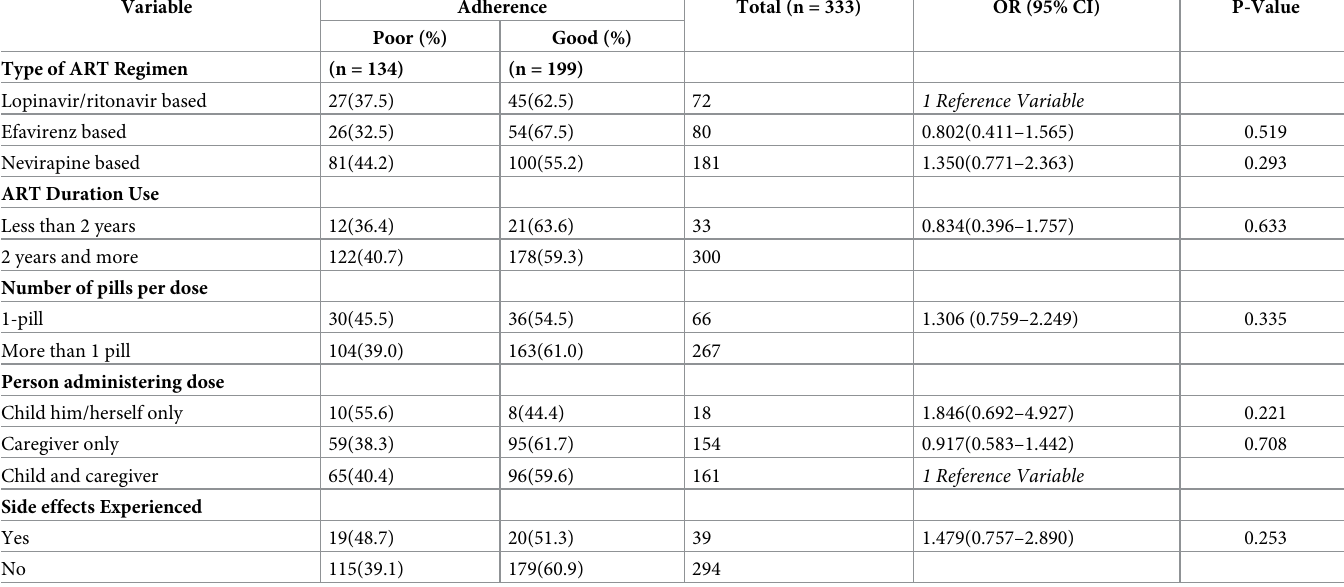
Table 4. Drug regimen related characteristics associated with ART adherence.